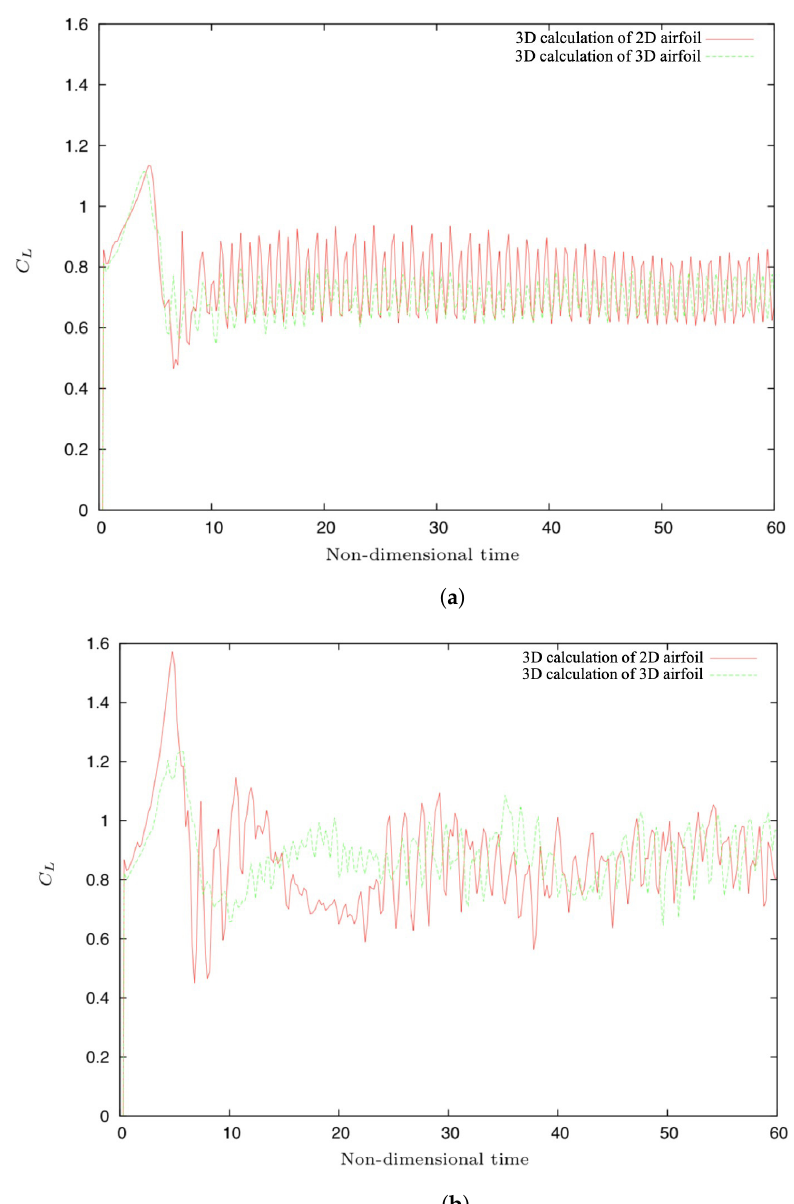
Figure 20. Time history of lift coefficient of 3D calculations for the 2D and 3D corrugated airfoil at Re = 2000 and 4000 with angle of attack of 8 ◦ : ( a ) Re = 2000; and ( b ) Re =